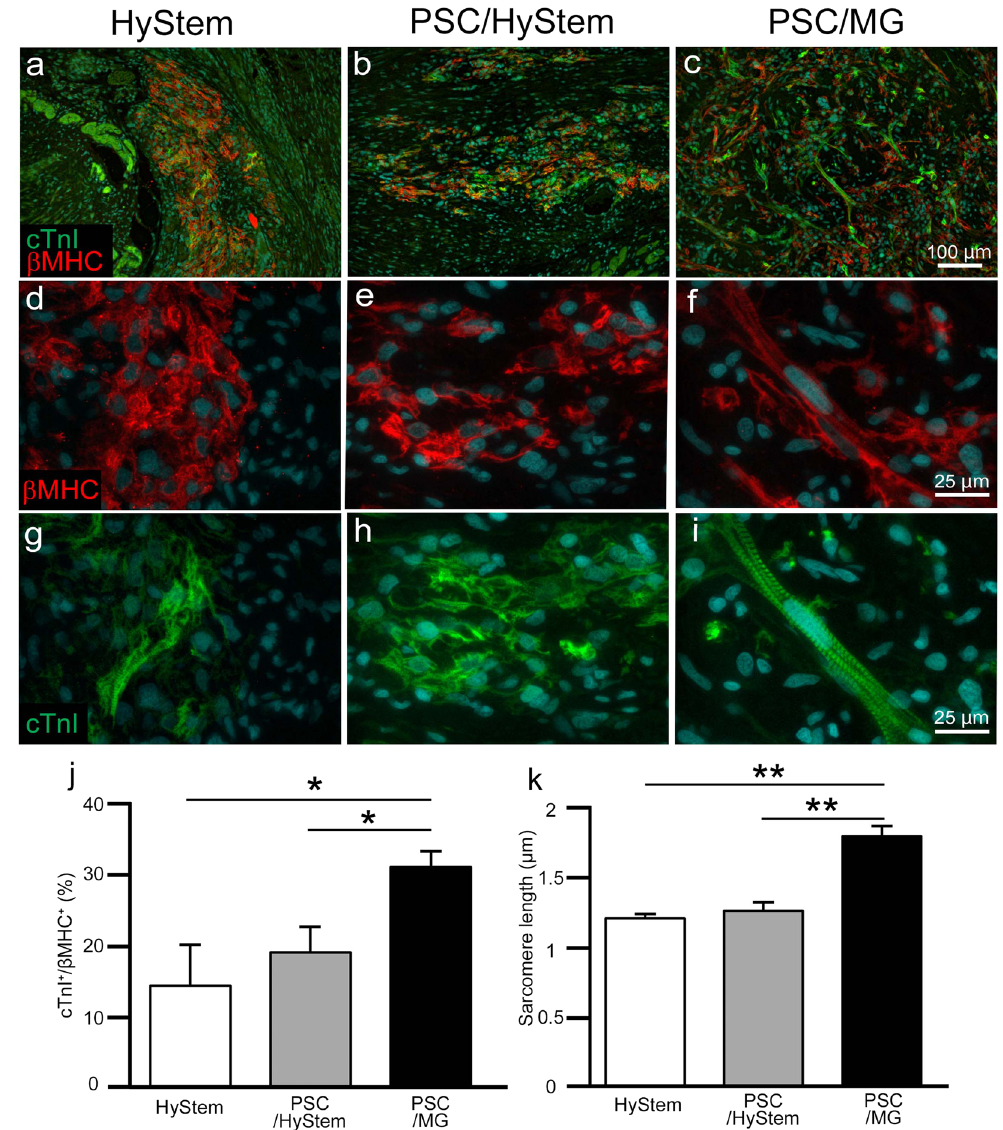
Figure 5. The maturation of grafted cardiomyocytes is shown. ( a – i ) Representative images of sections stained with cardiac troponin I (cTnI) and β -myosin heavy chain ( β MHC). Note that the antibody against β MHC reacts with human-derived graft cardiomyocytes but not with rat-derived host cardiomyocytes. ( d – i ) Magnified images of ( a – c ). While the sarcomere structure was easily observed in the grafts of the PSC/MG group, it was relatively rarely observed in the HyStem and PSC/HyStem groups. ( j ) % of cTnI-positive cells in all grafted cardiomyocytes, * P < 0.05. ( k ) Length of the sarcomere in grafted cardiomyocytes, ** P < 0.01. PSC, pro- survival cocktail; MG,